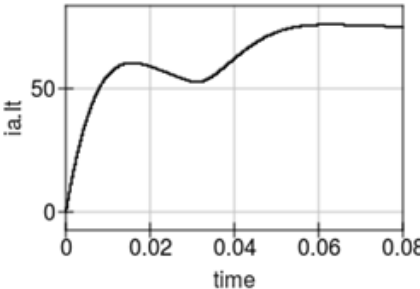
Figure 13. Load test results in Qucs for i a ( t ) . The load torque = 5 Nm.